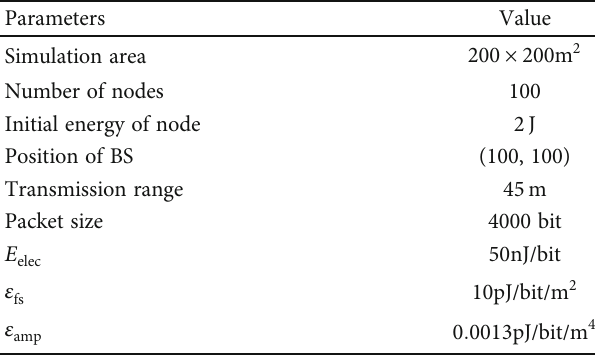
Table 2: Simulation